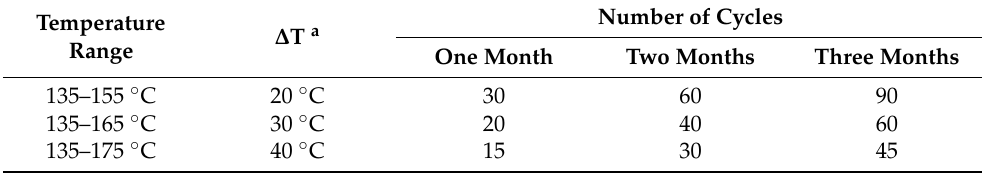
Table 1. Number of cycles for every temperature range/duration. Temperature